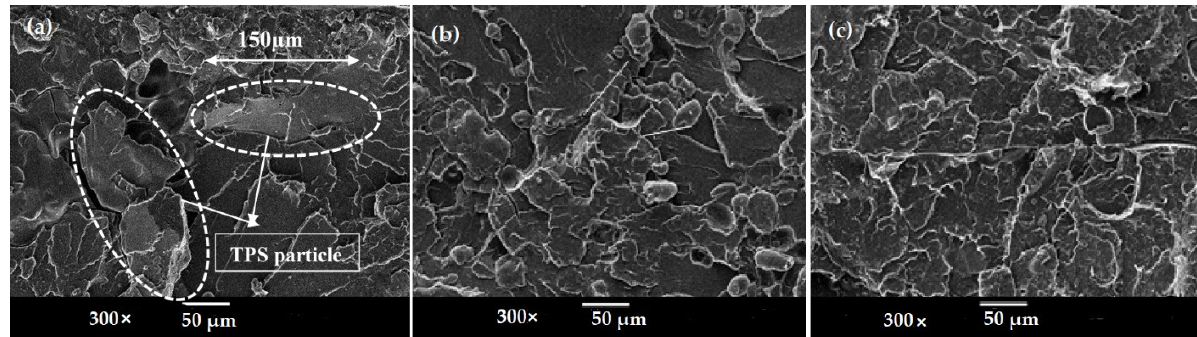
Figure 8. SEM micrographs of ( a ) untreated TPS/PS, ( b ) TPS/PS/SA, and ( c ) TPS/PS/AA with 20/80 proportion blends.